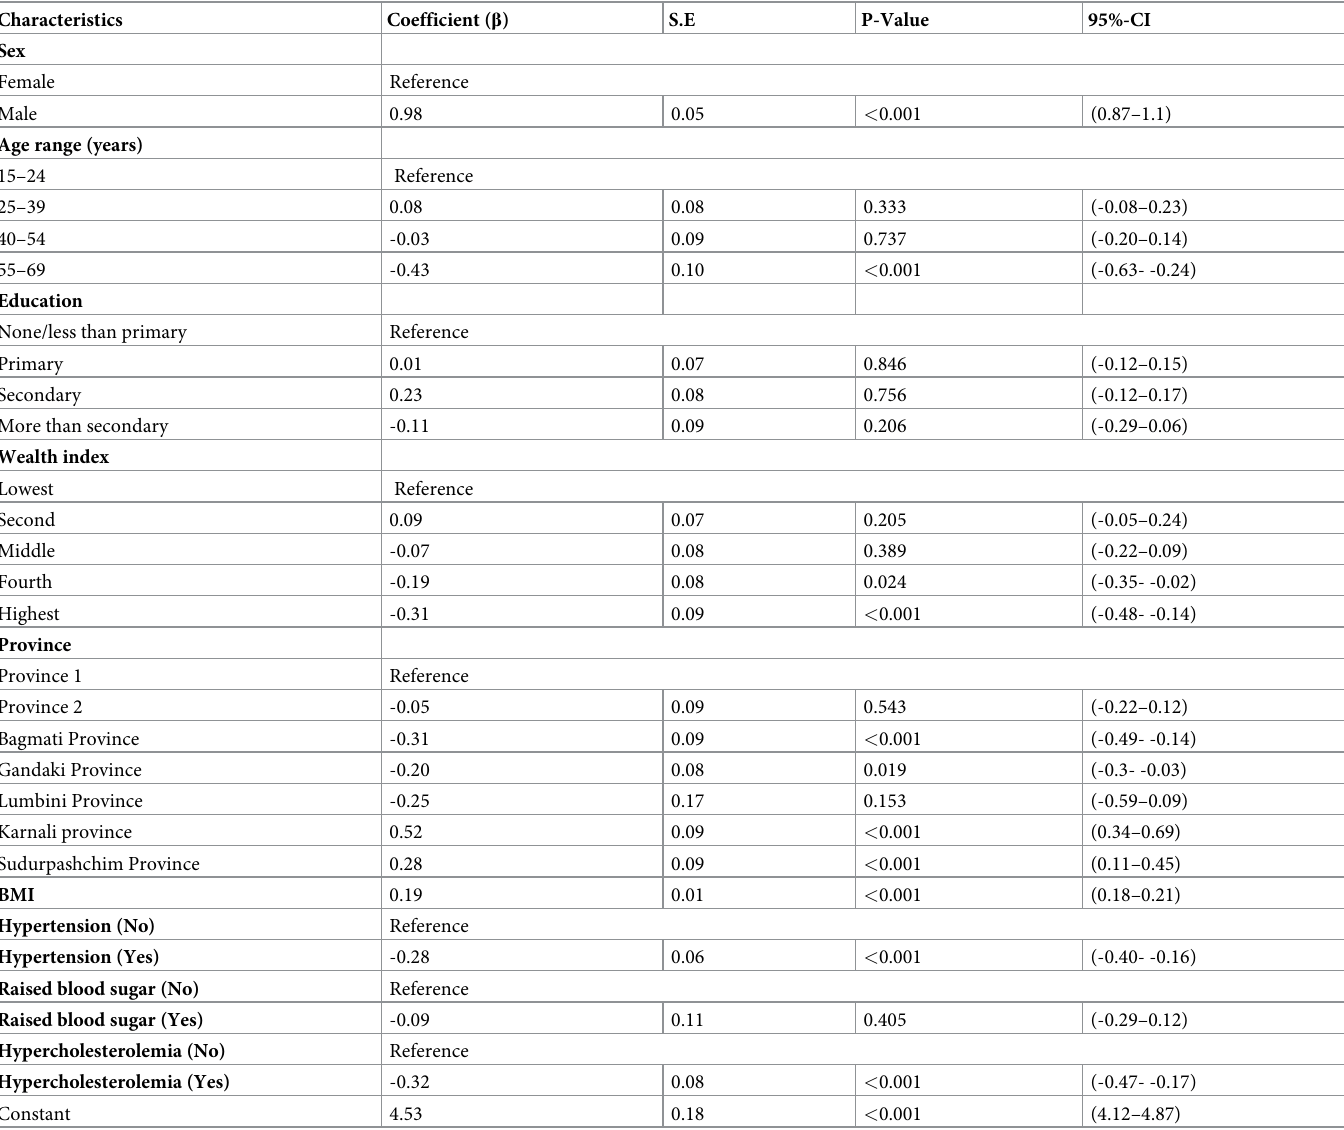
Table 4. Multivariable analysis of salt intake with participants’